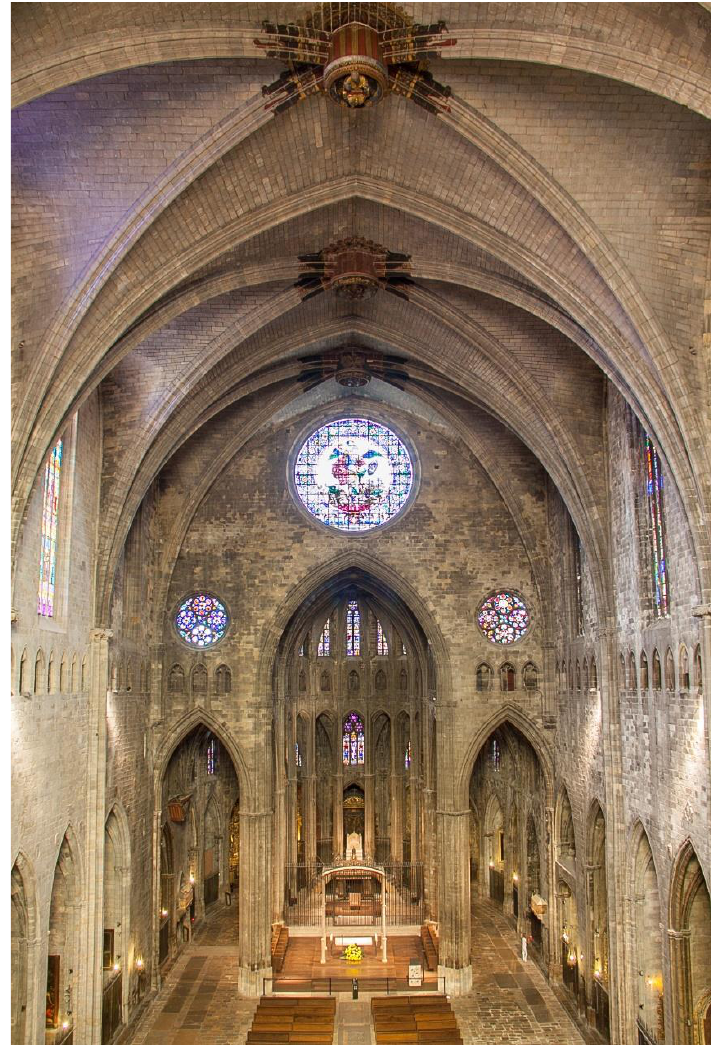
Figure 4. Image of the interior of the Girona Cathedral.